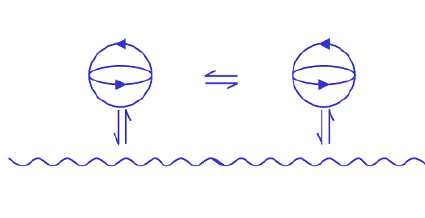
Figure 2. Maturana and Varela’s ideograms to denote structurally-determined autopoietic and operationally-closed systems. The diagram (denotes anorganizationally-closedautonomoussystemwithacentralnervous system. This system is capable of development by means of self- modification of its nervous system, so that it can accommodate a much larger space of effective system action.